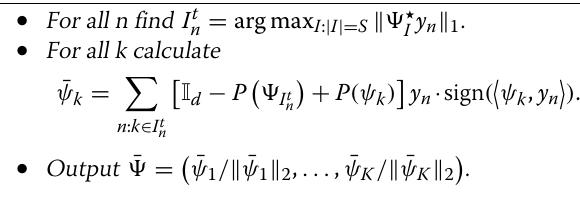
Algorithm 1 (ITKrM - one iteration) Given an input dic- tionary (cid:12) , a sparsity level S and N training signals y